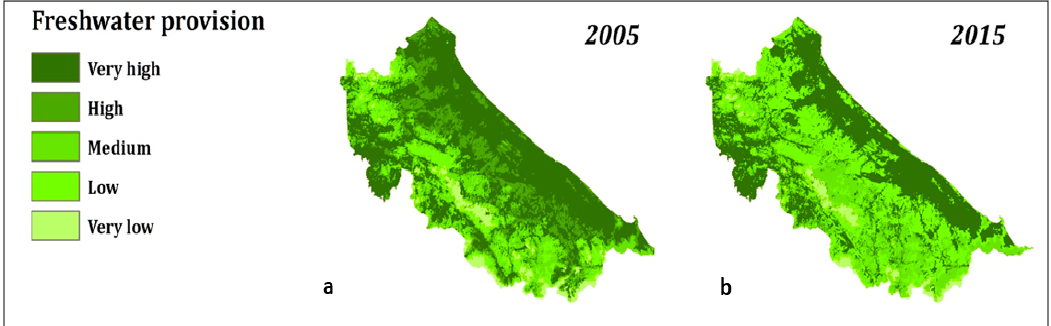
Figure 4. Distribution of landscape capacity to supply freshwater provision across the study area. ( a ) Landscape capacity to supply freshwater provision in 2005; ( b ) the landscape capacity to supply freshwater provision in 2015. The area with dark green colors shows the low capacity to supply freshwater, where the area with light green indicates the medium capacity and the area with yellowish-green designates the high capacity to supply freshwater provision.